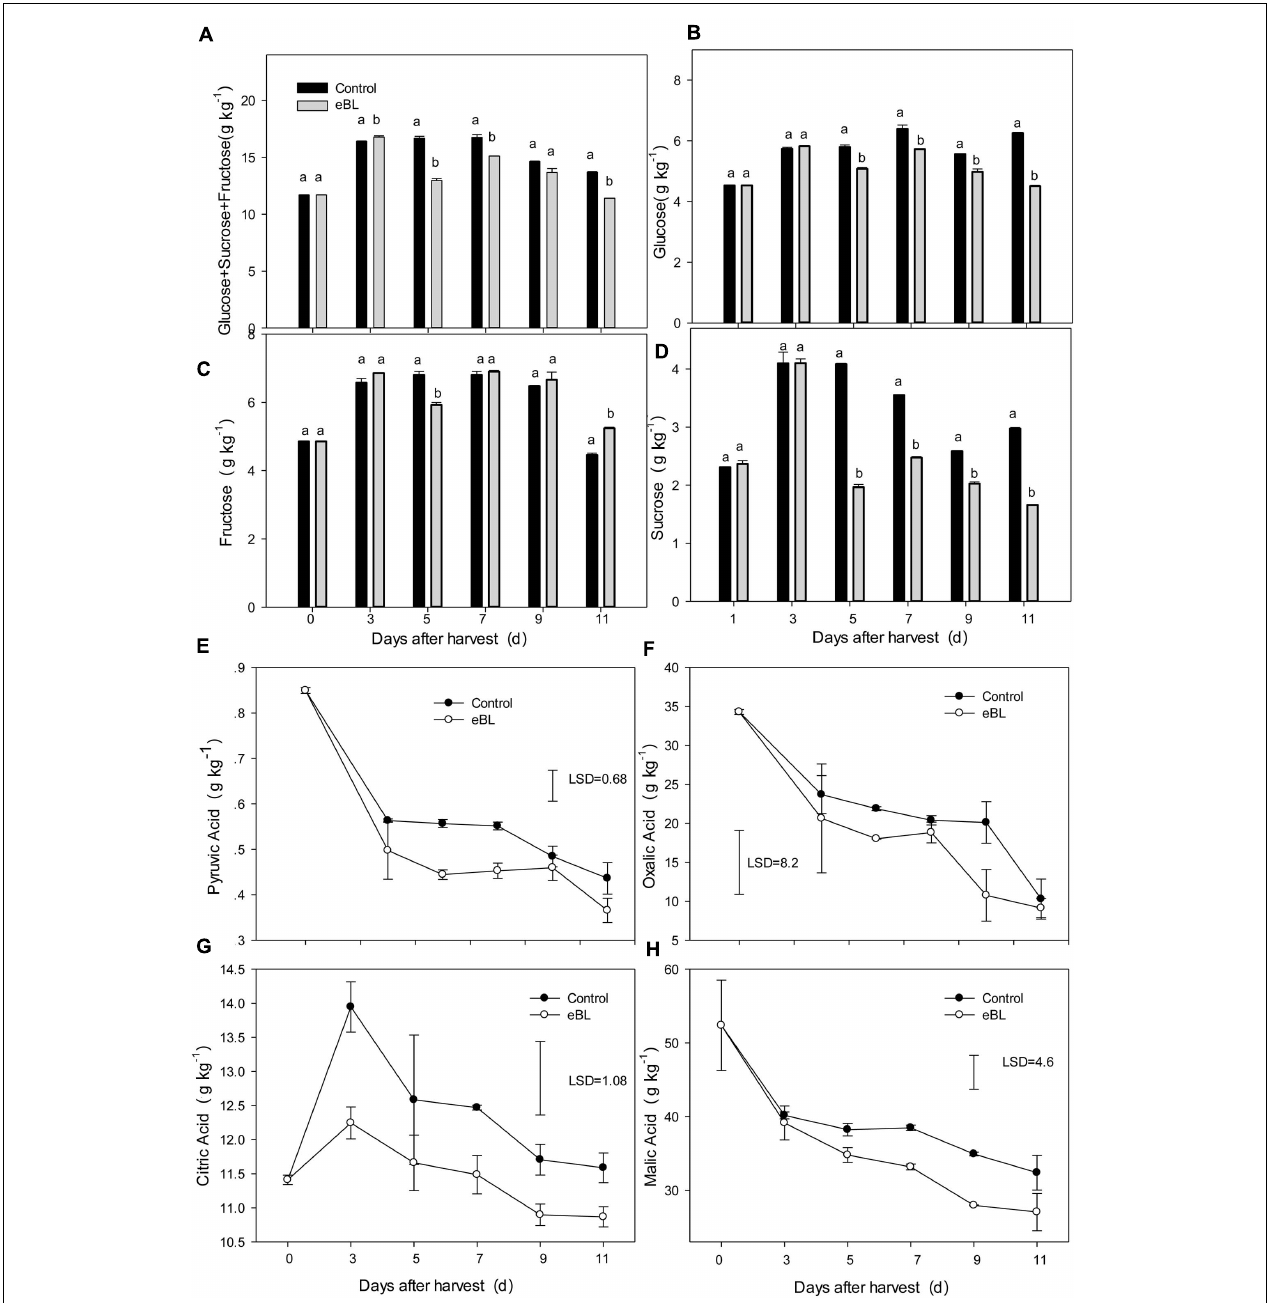
FIGURE 3 | Effects of eBL treatment on the content of sugars and organic acids. (A) The total content of glucose, fructose, and sucrose; (B–D) the total content of glucose (B) , fructose (C) , and sucrose (D) ; (E–H) the total content of pyruvic acid (E) , oxalic acid (F) , citric acid (G) , and malic acid (H) . Least significant differences (LSDs) were calculated to compare significant effects at the 5% level. Each data point represents the mean ± S.E. ( n =